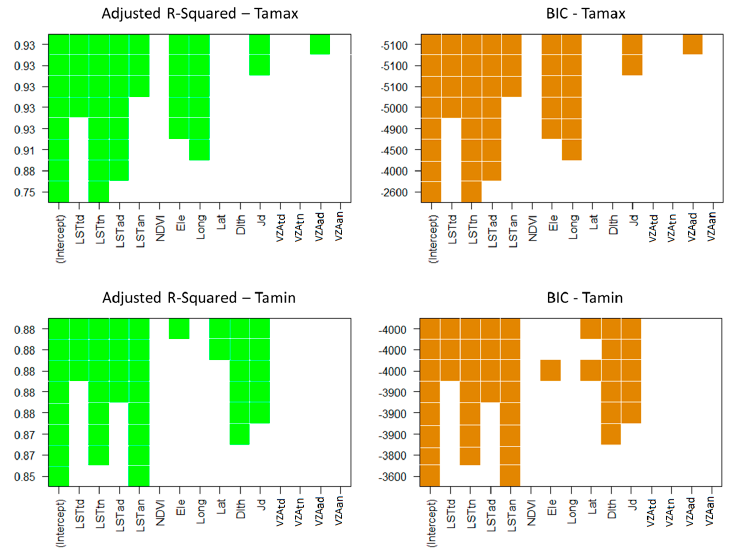
Figure 2. Ranking of models based on R 2 and BIC criteria for T a-max ( upper row panel ) and T a-min ( lower row panel ) estimation. Table 4. Pearson correlation coefficients of all variables considered in models for daily T a-max and T a-min estimation.